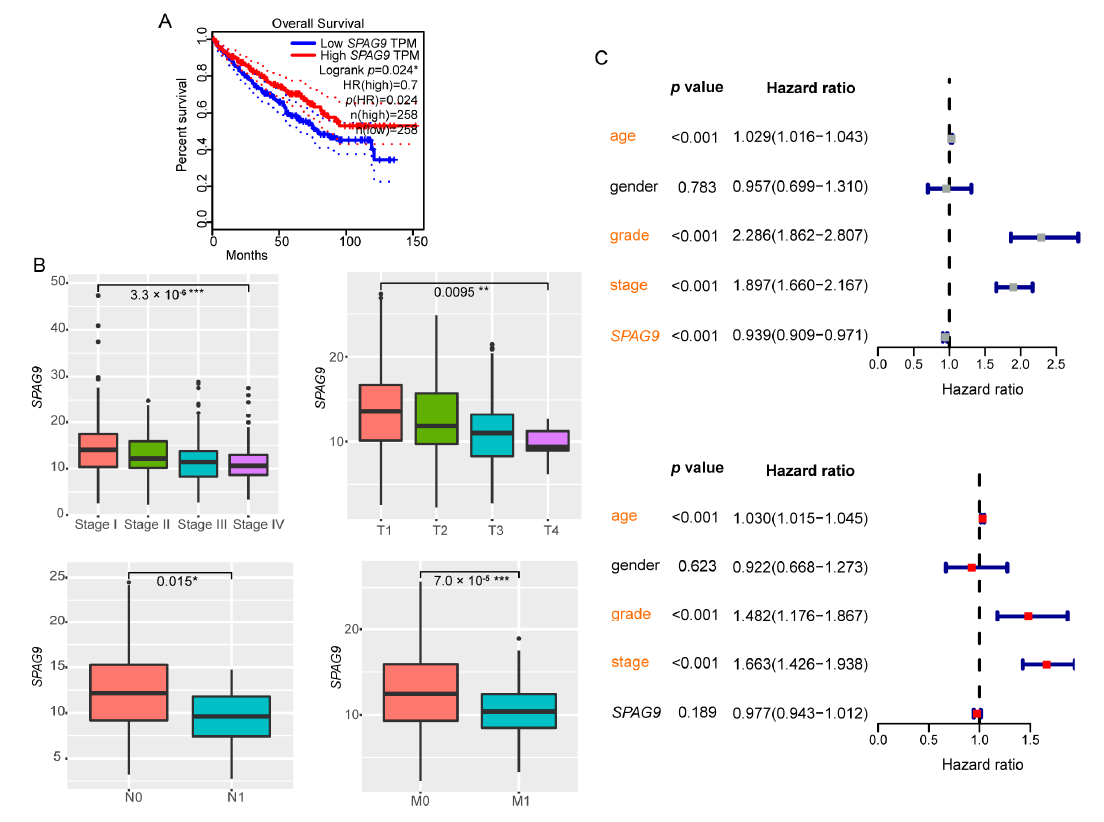
Figure 1. Survival analysis of SPAG9 in ccRCC. ( A ) Kaplan–Meier survival analysis of 516 ccRCC patients was performed using GEPIA2 online tool. Median SPAG9 TPM was chosen as the group cutoff. The 95% CI is shown by the dotted lines. ( B ) The SPAG9 -expression differences between stages, T, N, and M in ccRCC patients. Wilcoxon rank-sum test served as the statistical significance test. ( C ) Univariate ( top ) and multivariate ( bottom ) Cox regression analyses of SPAG9 expression and other clinicopathologic variables in ccRCC. Significant results are marked in orange. * p value < 0.05, ** p value < 0.01, *** p value < 0.001.